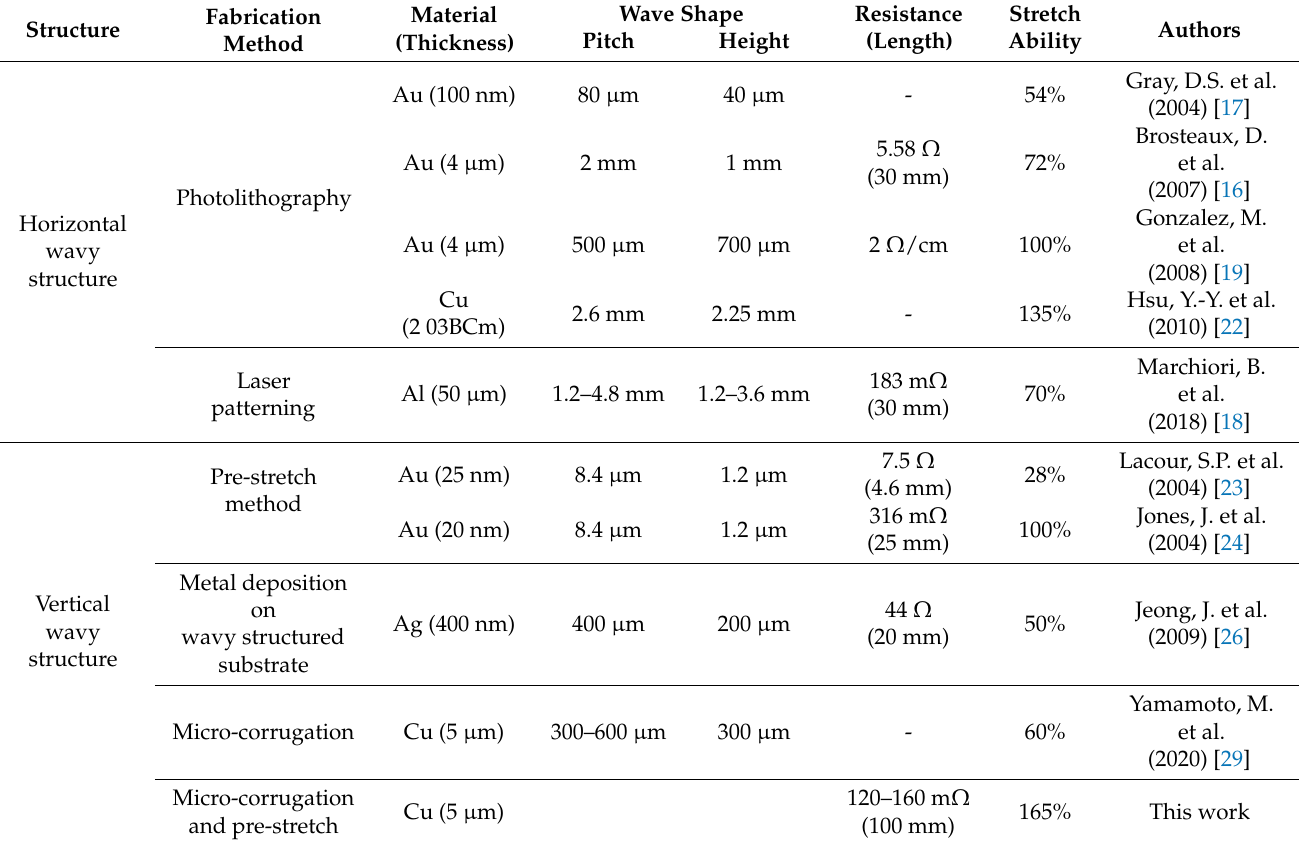
Table 2. Comparison between the proposed method and previous studies on wavy structured metal